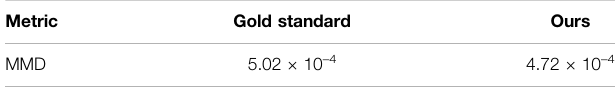
Values represent mean (±standard deviation) in all cases TABLE 6 | Difference in randomly generated multi-modal distributions combining MRI-based anatomy and ECG-based electrophysiology.